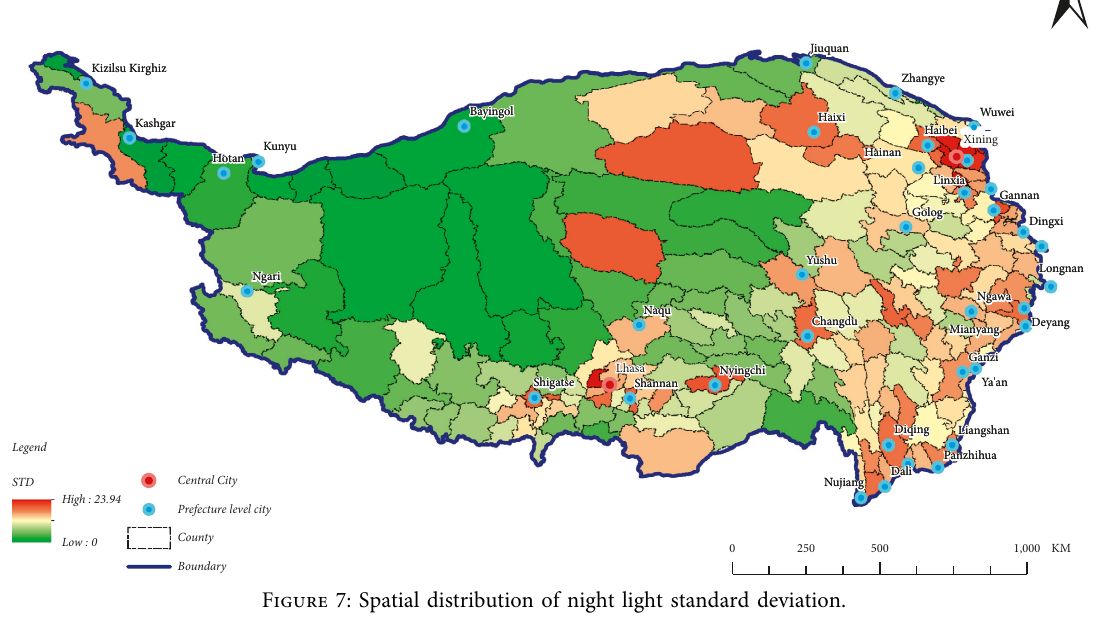
Figure 7: Spatial distribution of night light standard deviation.